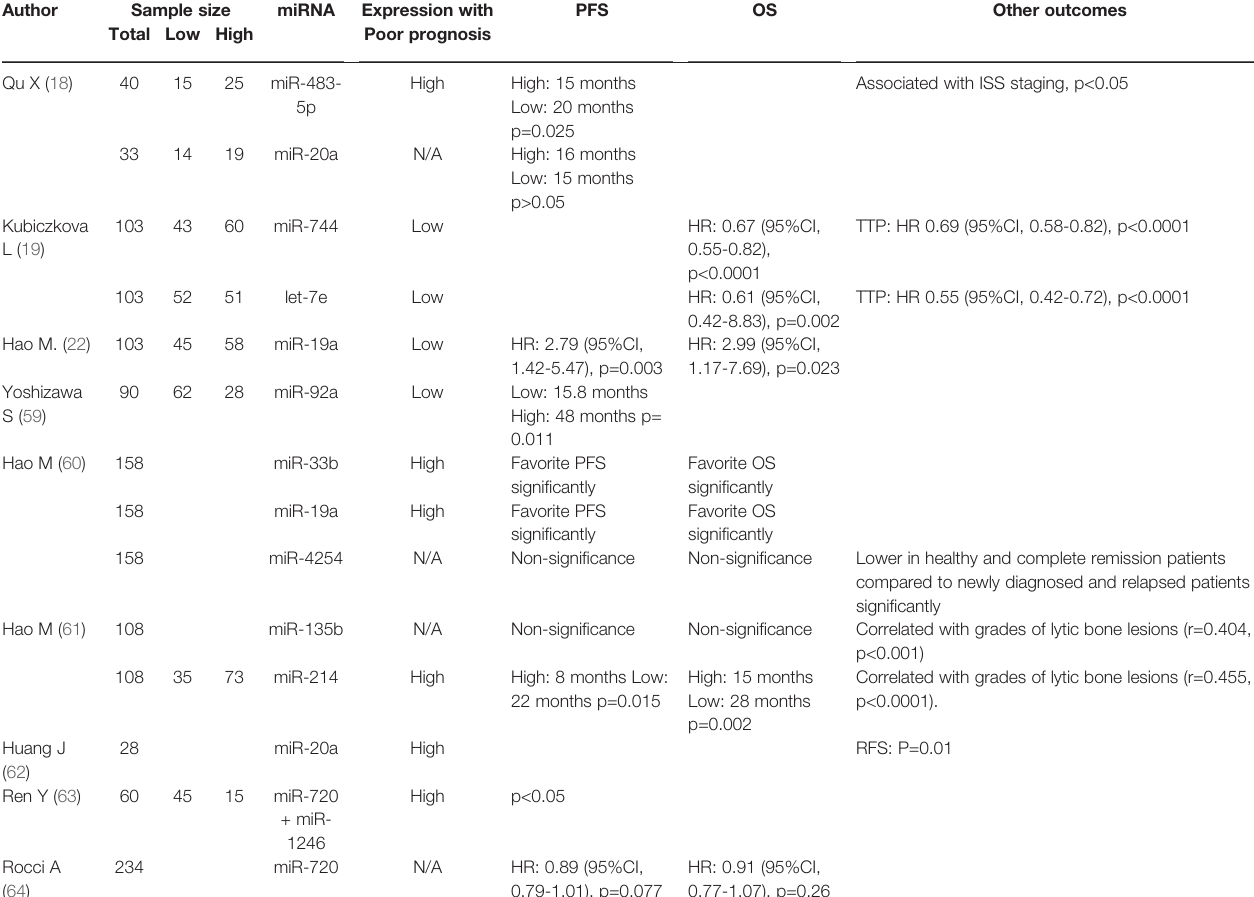
TABLE 7 | The prognostic value of circulating miRNAs in multiple